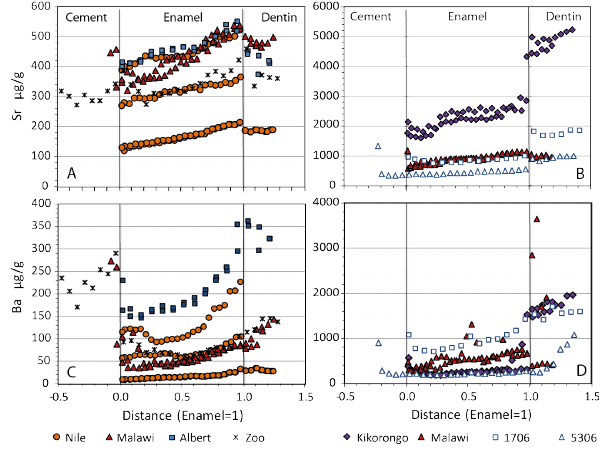
906 907 Fig. 2. Ba and Sr variations along selected tooth profiles from the outside margin through cementum, enamel into dentin. Several specimens (modern and fossil Malawi; modern Lake Albert; Lake Kikorongo) are represented by data along apical and cervical pro- file locations. Significant differences of concentrations and gradi- ents are not observed. The distance is normalized to the length of the enamel = 1. (a, c) Ba and Sr variation in modern enamel. (b, d) Ba and Sr variation in fossil